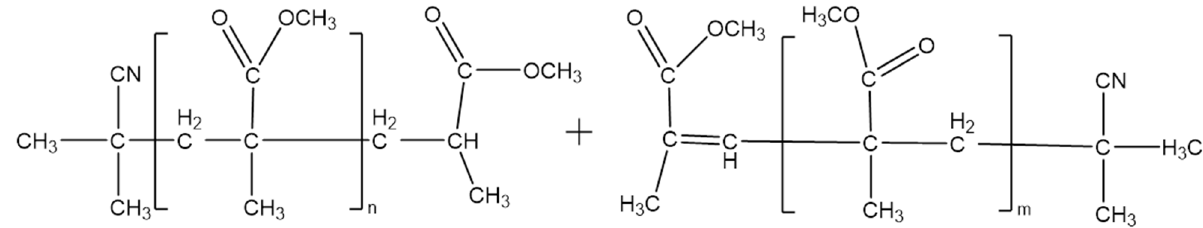
Figure 11. Disproportionation termination products.